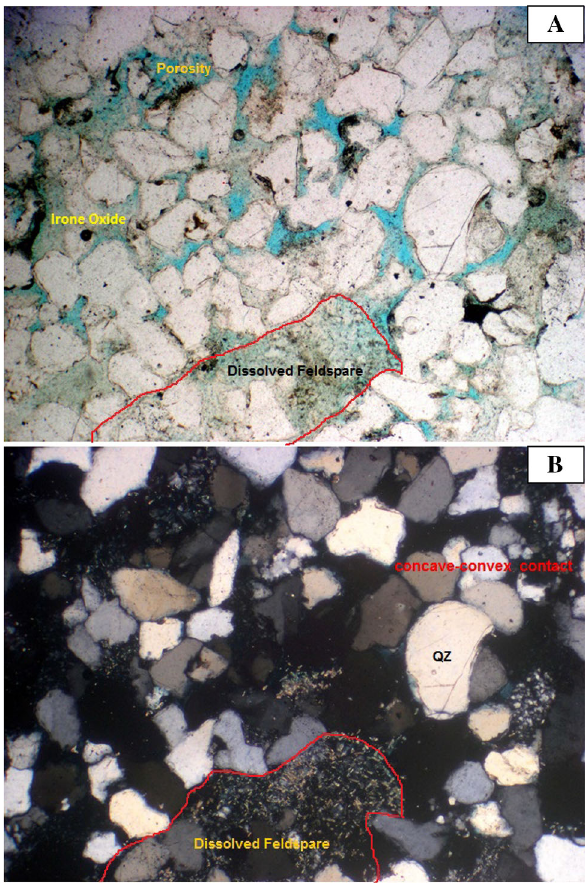
Fig. 12 Photomicrographs showing the quartz arenite microfacies with partially dissolved feldspar, iron oxide cement and intergranular